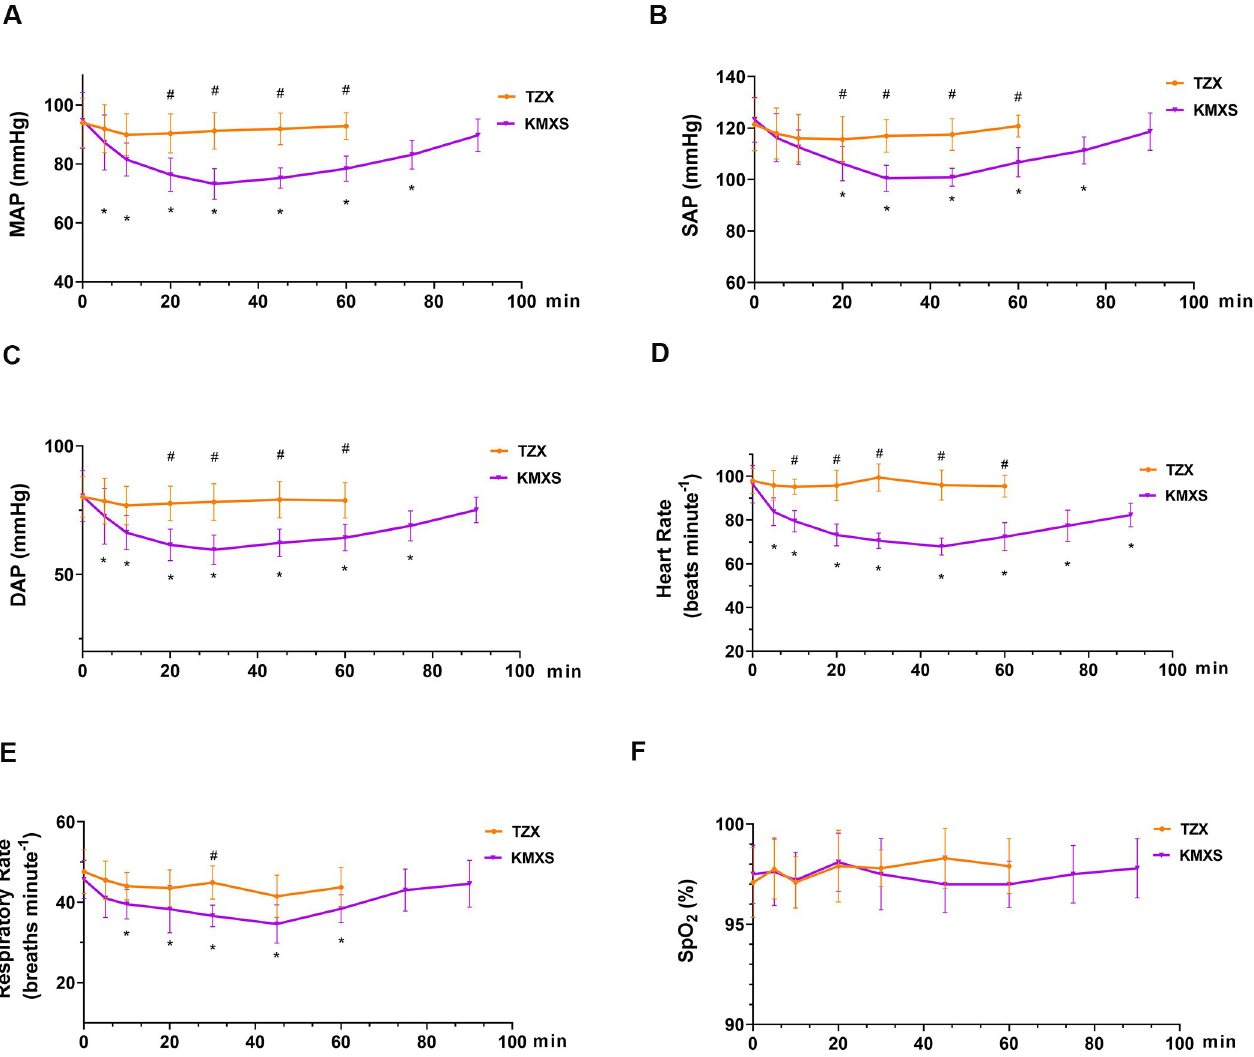
Fig 4. Cardiopulmonary variables in pigs (n = 10) that were treatmented with with KMXS or TZX protocol at phase 1. (A) mean arterial pressure (MAP), (B) systolic arterial pressure (SAP), (C) diastolic arterial pressure (DAP), (D) Heart rate (HR), (E) Respiratory rate (RR), and (F) peripheral hemoglobin oxygen concentration (SpO 2 ). KMXS protocol, 10 mg kg -1 ketamine, 0.5 mg kg -1 midazolam, and 2 mg kg -1 xylazine, plus 2 μ g kg -1 sufentanil. TZX protocol (n = 8), 4.4 mg kg -1 tiletamine-zolazepam plus 1.4 mg kg -1 xylazine. Values are expressed as mean ± standard deviation (SD). � Significantly different from baseline at the same group ( p < 0.05); # Significantly different between treatment groups ( p <